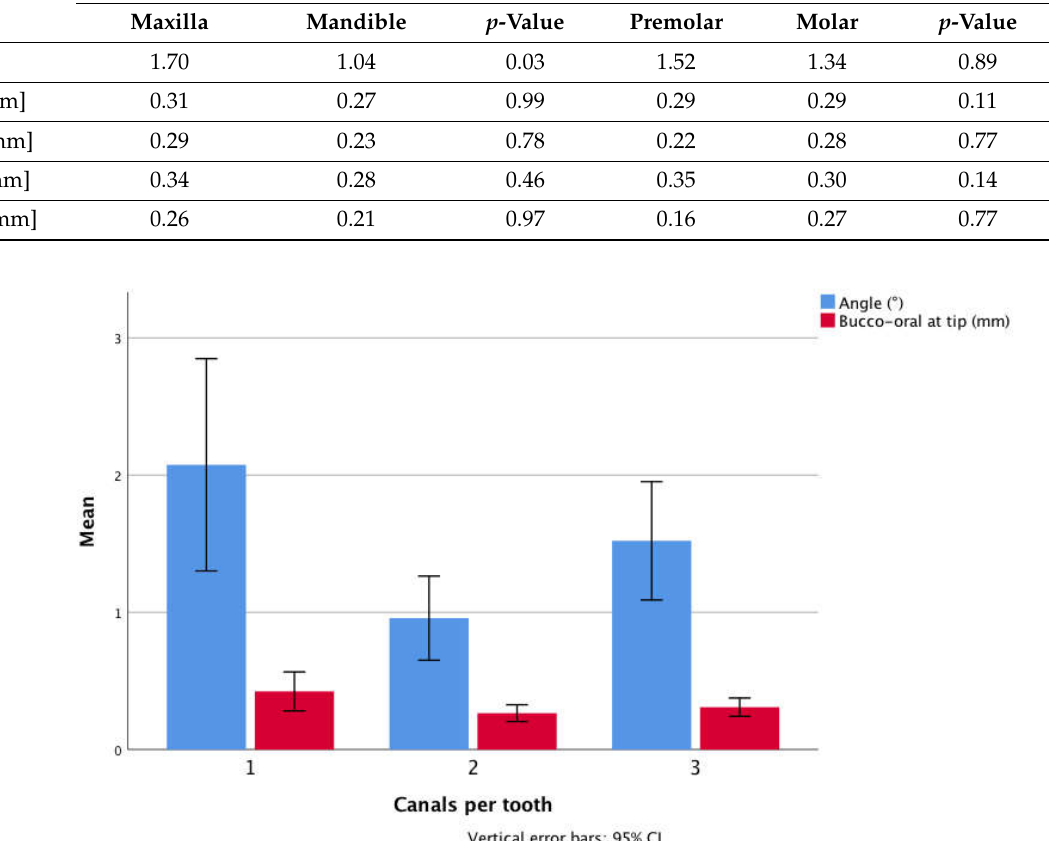
Figure 5. Mean angle deviation ( ◦ ) and mean deviation at the tip of the bur in the bucco-oral dimension (mm) for teeth with one, two or three main root canals, respectively. Table 3. Mean difference in angle deviation between planned and prepared access cavities according to the number of main root canals per tooth (CPT).